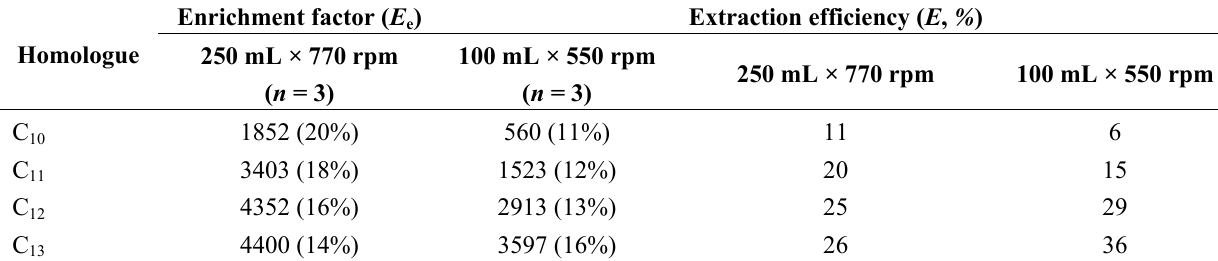
Table 1. Effects of sample volume and stirring speed (relative standard deviations (RSD) in brackets). Time was 15 h for 250 mL and 20 h for 100 mL. Other conditions as in